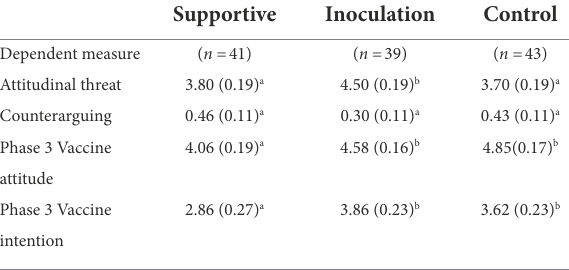
TABLE 2 Mean comparisons for dependent measures as a function of experimental